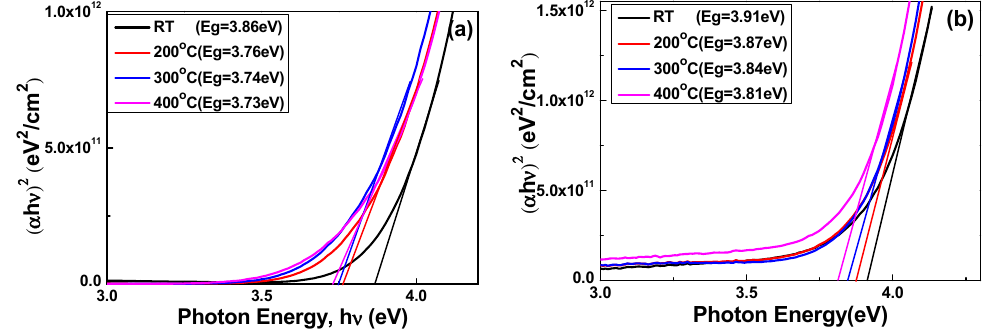
Figure 4. The ( α hv ) 2 versus h ν − E g plots of Nb 2 O 5 thin films as a function of deposition temperature and O 2 ratio. ( a ) O 2 ratio 10% and ( b ) O 2 ratio 20%, respectively.